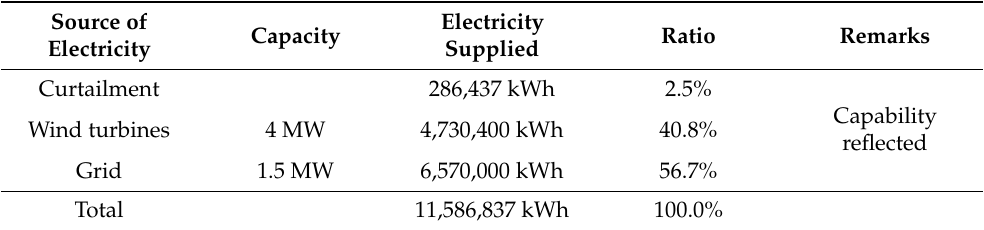
Table 17. The annual amount of electricity to be supplied to water electrolysis (Scenario II).